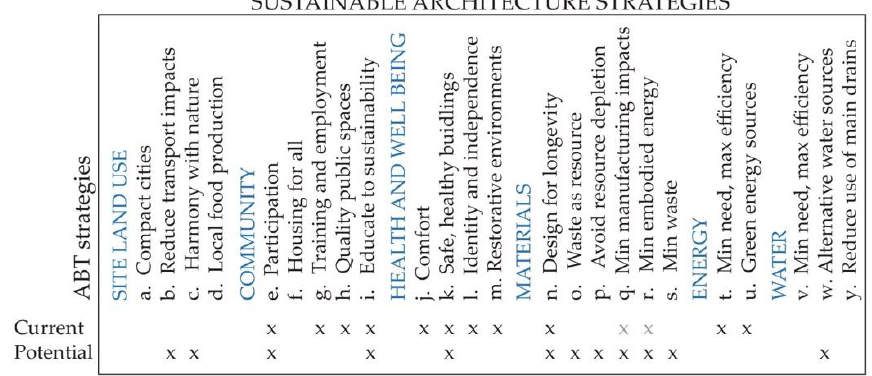
Figure 2. Current and potential impact strategies of Adaptive Building Technologies [5,8] within specific categories of the SAS [14]. specific categories of the SAS